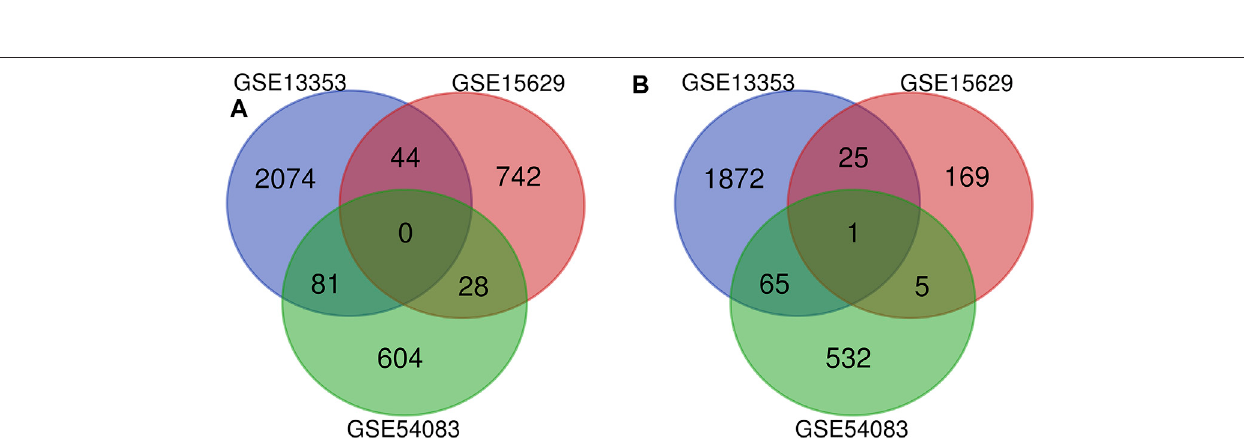
Frontiers in Genetics |